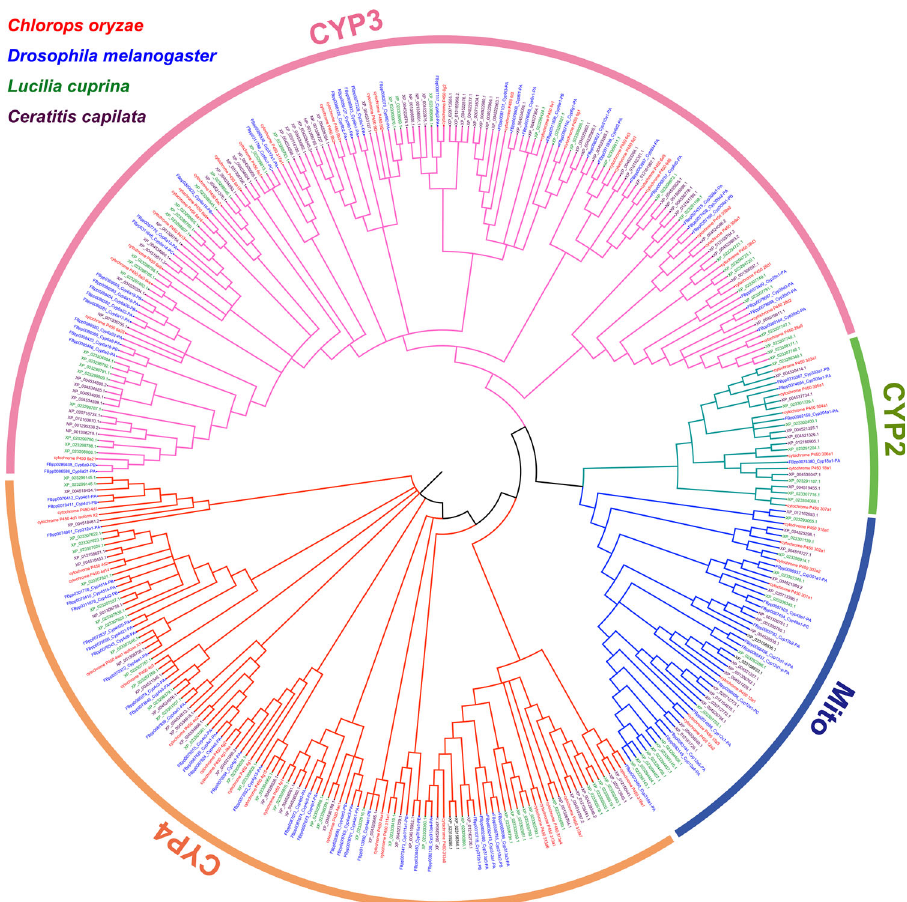
Fig. 4 Phylogenetic tree of the cytochrome P450 (P450) gene family of Chlorops oryzae and other insects. The phylogenetic tree of the P450 gene family was constructed using genes from Chlorops oryzae , Drosophila melanogaster , Lucilia cuprina , and Ceratitis capilata . The Neighbor-Joining (NJ) tree was constructed using MEGA v.7.0. with the Poisson correction method and 1000 bootstrap replicates and optimized with iTOL software.